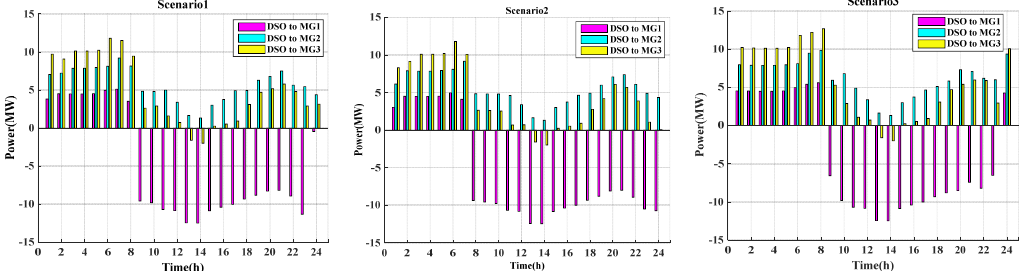
Figure 11. Exchanged power between DSO and MGs in different scenarios for CS3: ( a ) scenario 1; ( b ) scenario 2; ( c ) scenario 3.